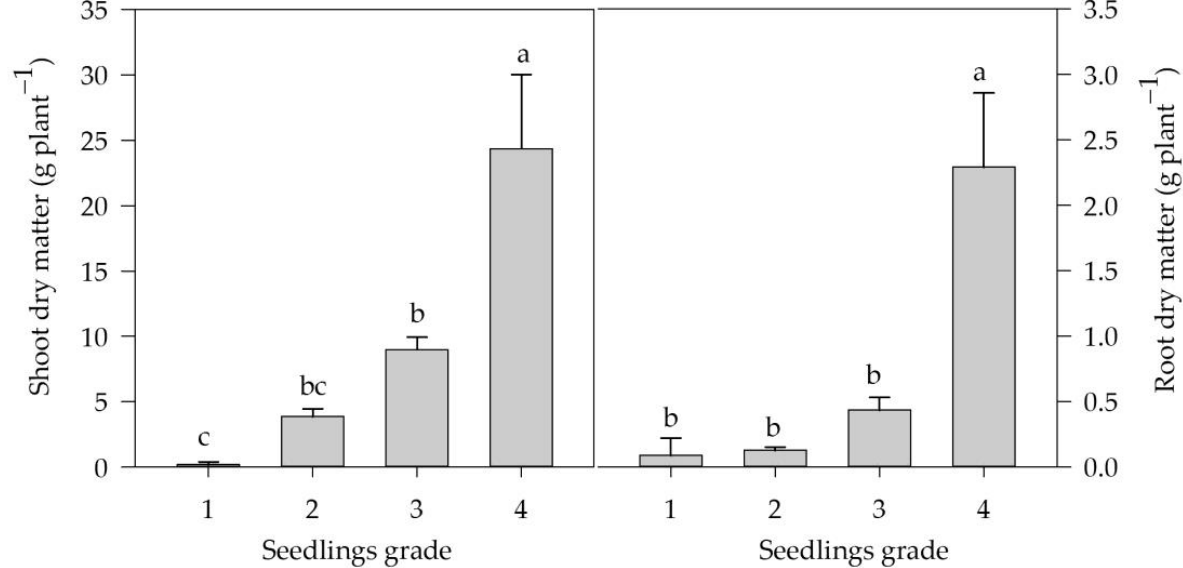
Figure 4. Shoot and root dry matter per plant in the four grades of tall wheatgrass seedlings grown in different saline-alkaline soils. Data were represented as mean ± SD. Different letters indicate a significant difference at p < 0.05.